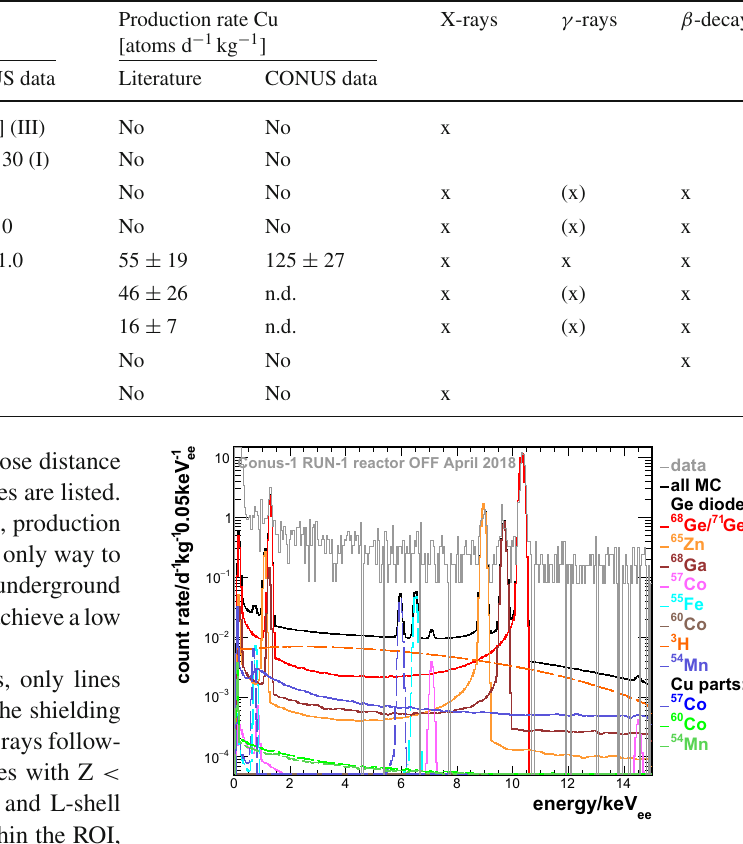
the overlapping L-shell lines are combined to a single broad peak. Within the highE range, additional lines from the decay of 57 Co within Ge and Cu can be seen. The 121.1keV